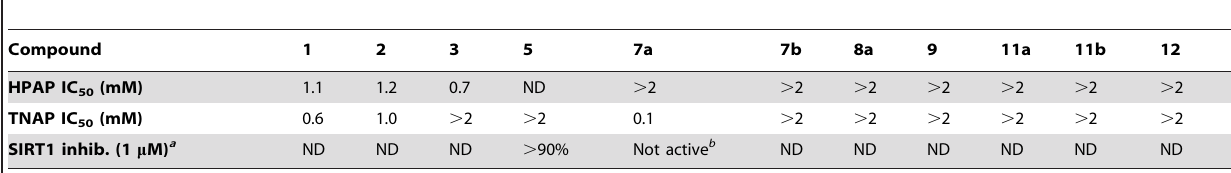
Table 2. Inhibition of human placenta alkaline phosphatase (HPAP), bovine kidney tissue non-specific alkaline phosphatase (TNAP) and sirtuin 1 (SIRT1) by selected compounds.